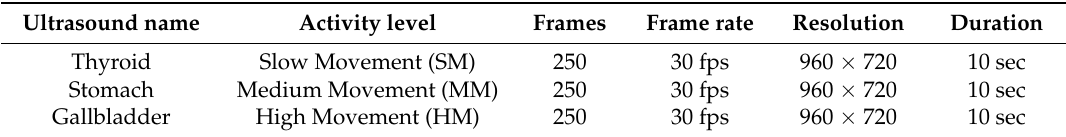
Table 1. Medical video content